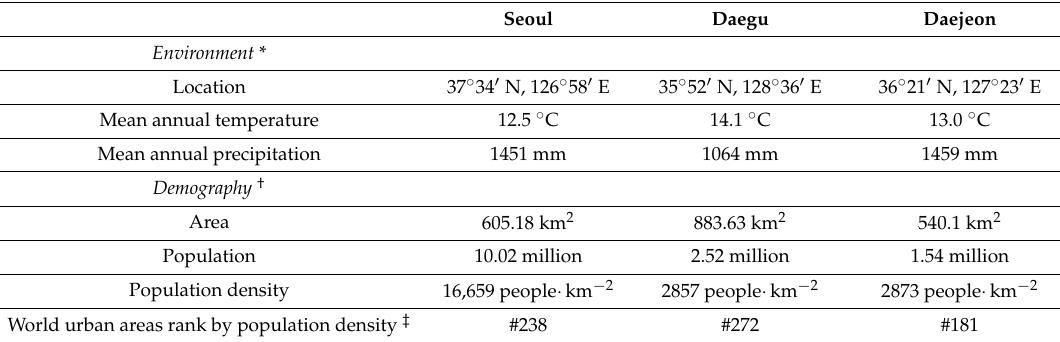
Table 1. Environmental, demographic, and land use characteristics of the three studied